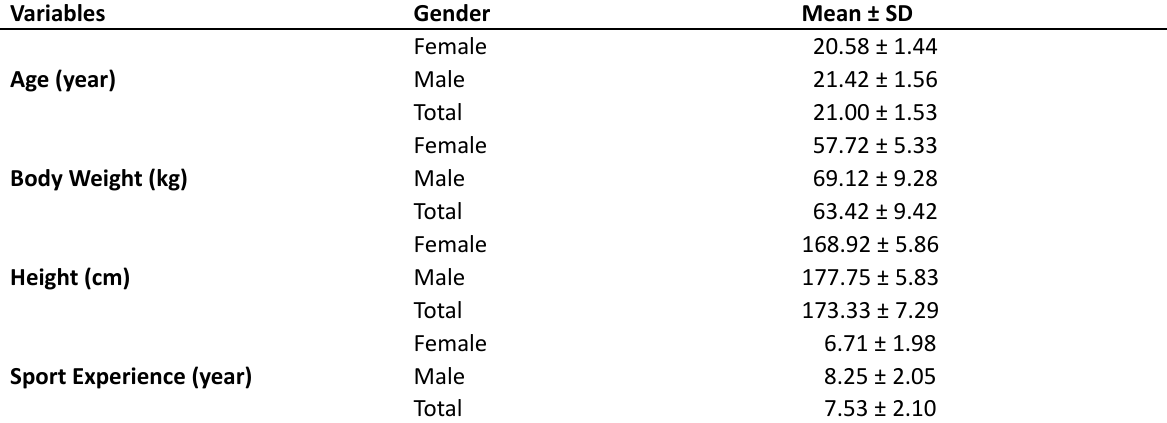
Table 1. Subjects’ physical characteristics.